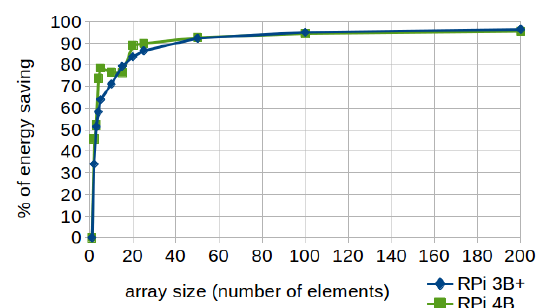
Figure 4. Cascaded function calls. Percentage of energy saving according to the number of calls to the function (number of iterations of the loop) in RPi 3B+ and 4B.